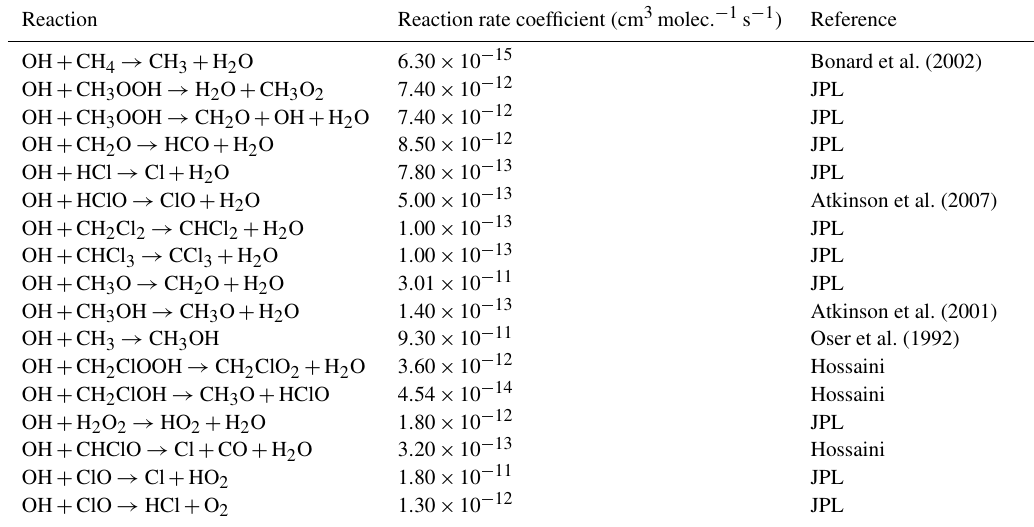
Table E2. JPL: Burkholder et al. (2020). Hossaini: Hossaini et al. (2016). Reaction